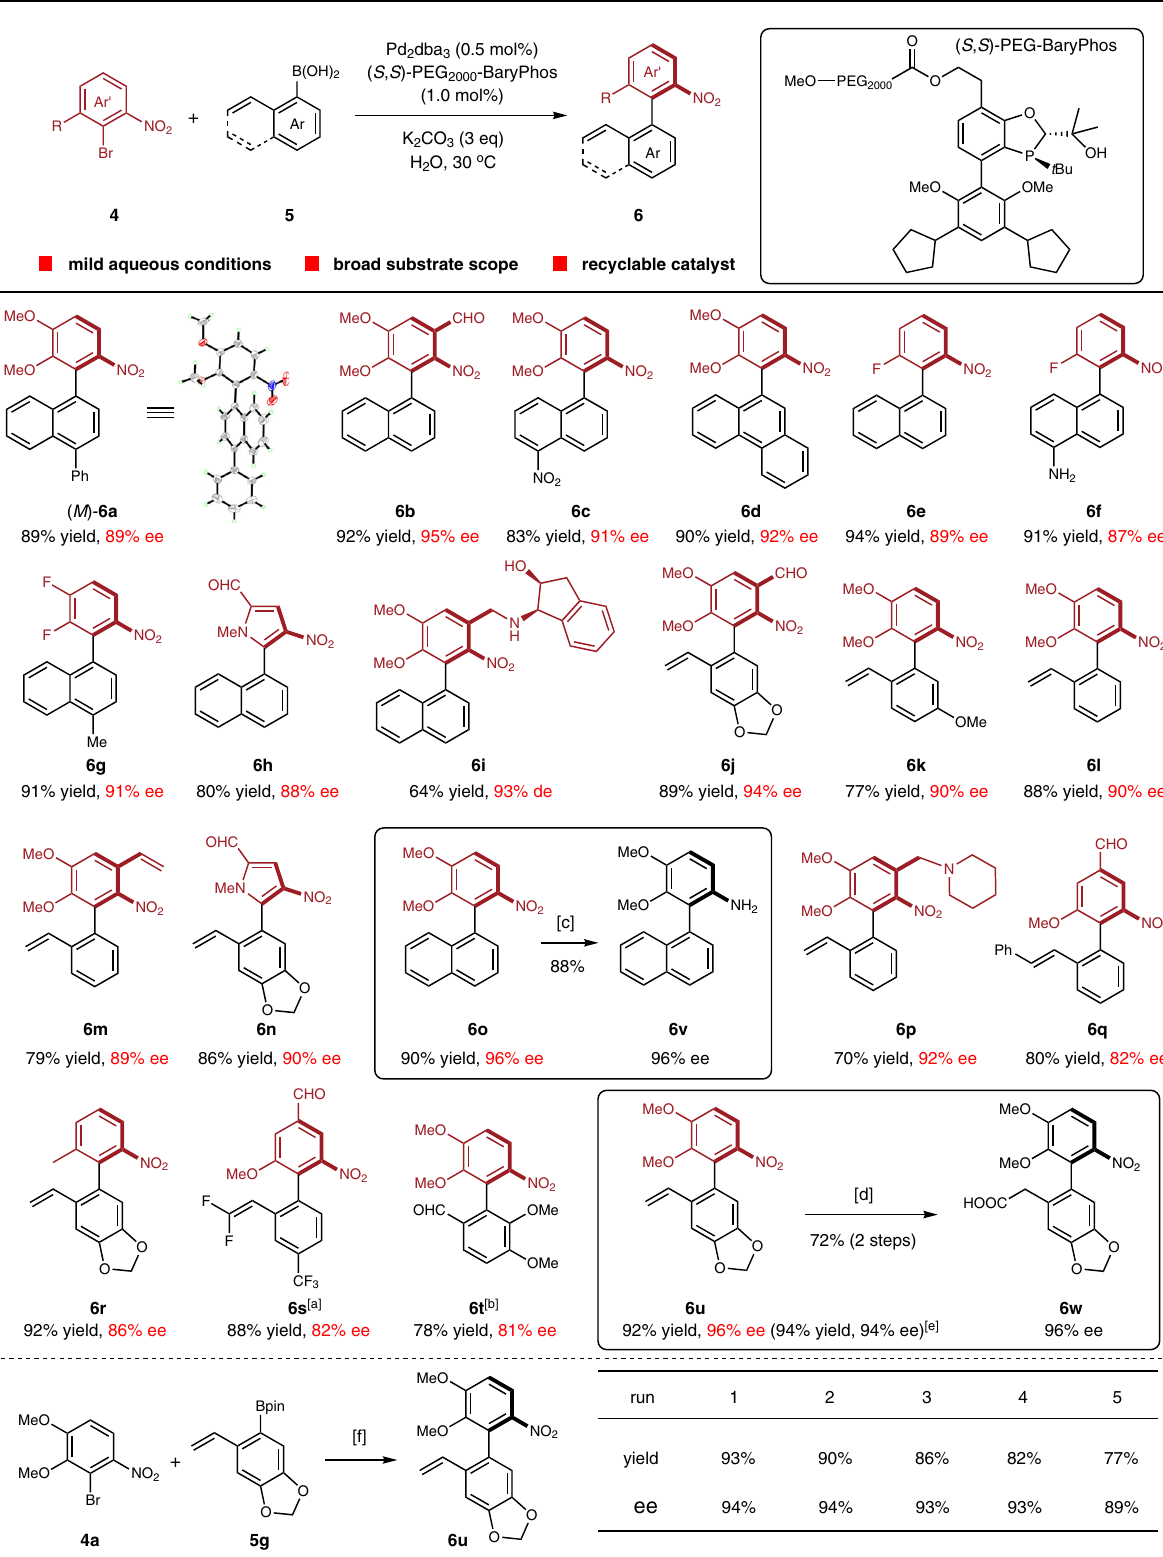
corresponding potassium aryltri fl uoroborate was employed and the reaction was conductedat70°C. c Reactioncondition:Zn,NH 4 Cl. d Reactionconditions:1)BH 3 in THF, then NaOH (aq), H 2 O 2 (aq); 2) RuCl 3 , NaIO 4 . e Results in parentheses were for reaction using BaryPhos as ligand in Tol/H 2 O (5:1) at 30°C. f Reaction